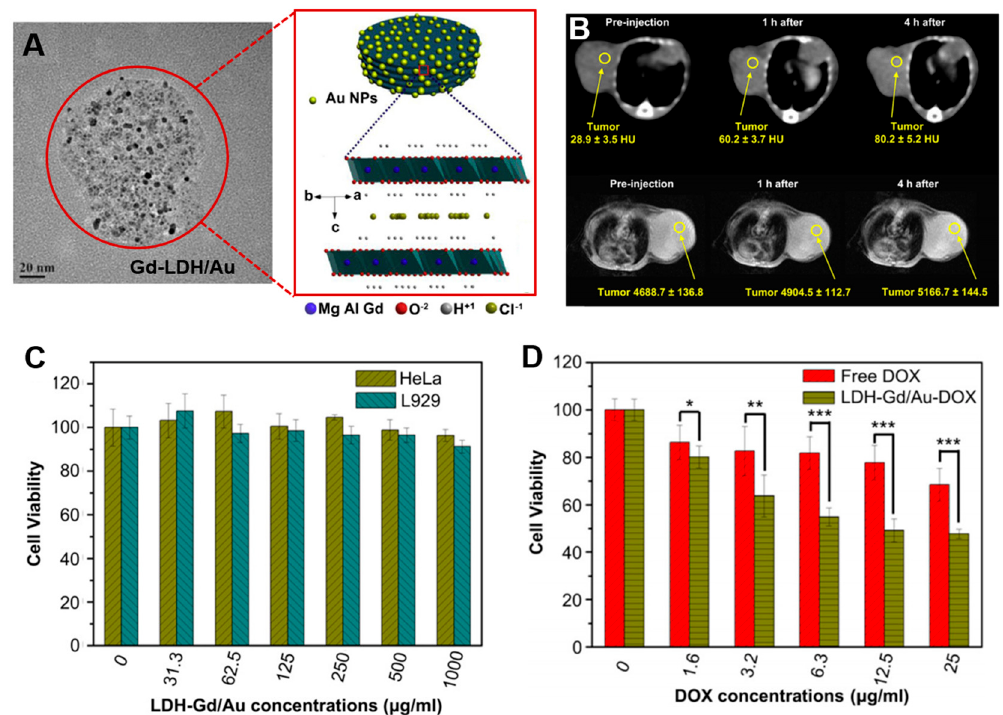
Figure 6. ( A ) SEM image (left) and schematic illustration (right) of LDH-Gd / Au. ( B ) CT (top) and MR images (bottom) of tumor after intravenous injection of Gd-LDH / Au-heparin in 4 T1 murine breast tumor-bearing mice. ( C ) Viabilities of L929 cell and HeLa cell incubated with LDH-Gd / Au nanocomposite without drug loading. ( D ) Viabilities of HeLa cell incubated with free DOX and Gd-LDH / Au-DOX at di ff erent concentrations, reproduced from [14].